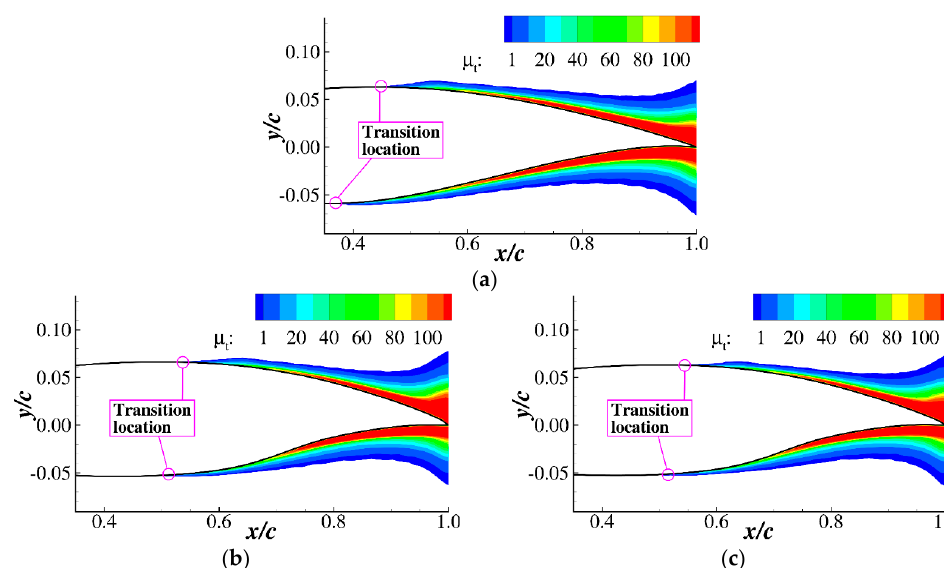
Figure 11. Eddy viscosity contours of the airfoils. ( a ) Initial airfoil; ( b ) optimized with ω = 0.02; and ( c ) optimized with ω = 0.04.